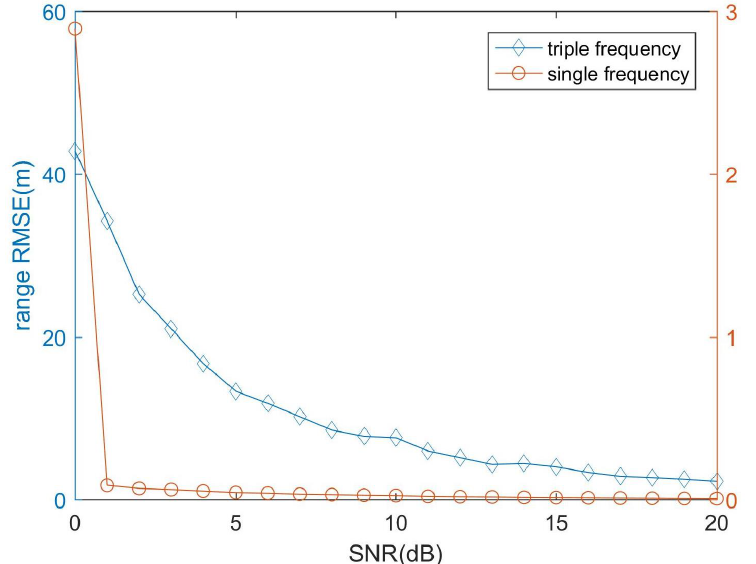
Figure 4. Variation in the ranging RMSE at various SNRs for single and triple